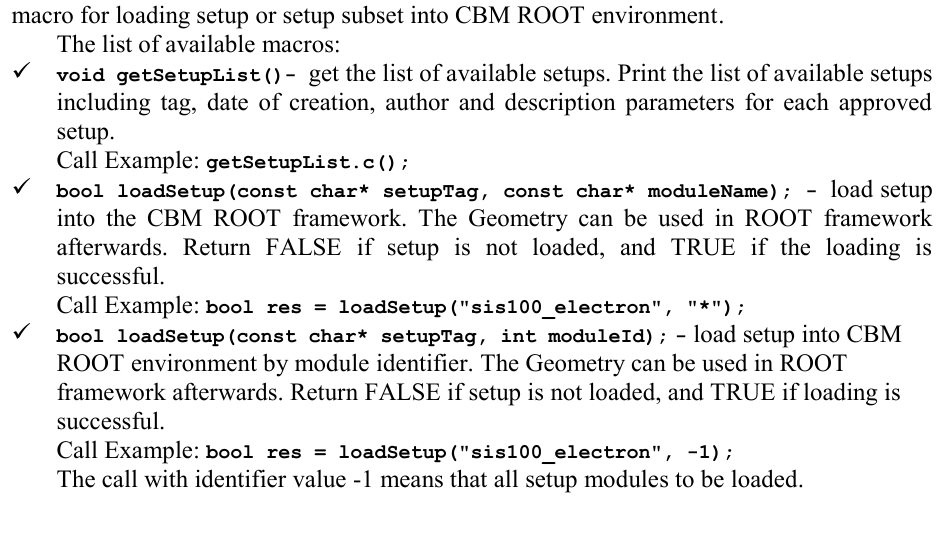
Fig. 6. Web-interface: Edit Mode.